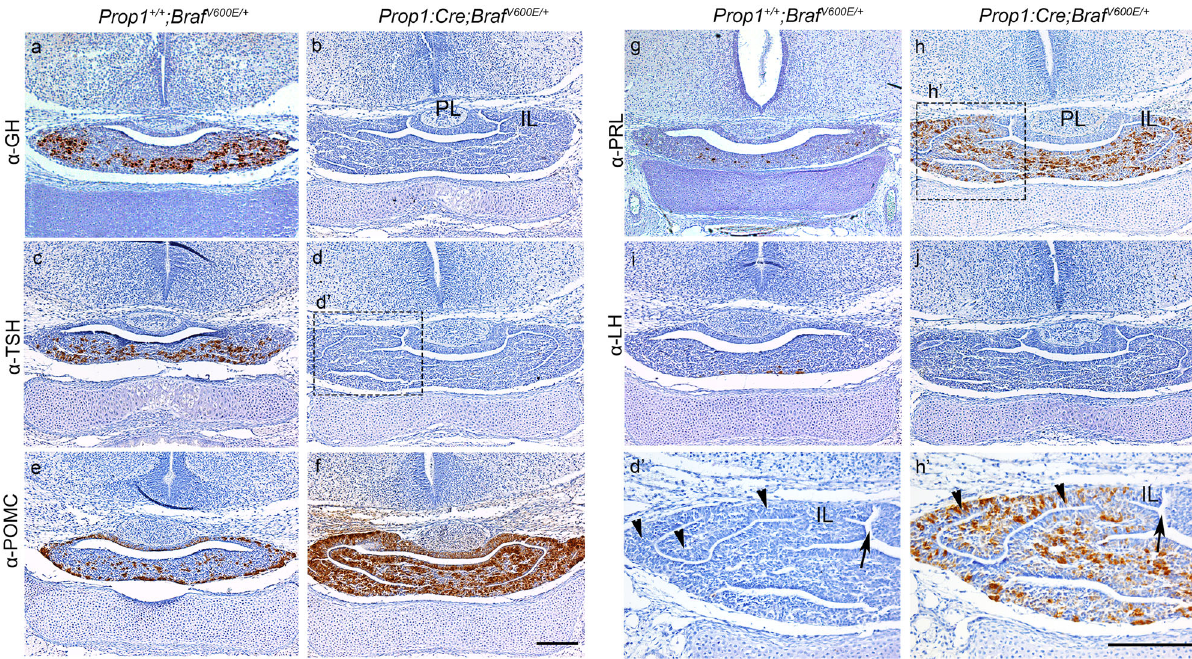
Fig. 4 Activation of the ERK/MAPK pathway in the anterior pituitary gland ( Prop1:Cre;Braf V600E/ + ) results in defective terminal differentiation of endocrine cells. a – j Immunohistochemistry against GH, TSH, POMC, PRL and LH in coronal sections through the pituitary gland of Prop1:Cre;Braf V600E/ + ( b , d , f , h , j ) and Wt ( a , c , e , g , i ) embryos at E17.5 of gestation. Absence of immunoreactivity for GH, TSH, LH in Prop1:Cre;Braf V600E/ + ( b , d , j ) mutant pituitaries compared to Prop1 + / + ;Braf V600E / + ( a , c , i ) reveals de fi cient terminal differentiation. Note that the anterior pituitary in Prop1:Cre;Braf V600E/ + is enlarged compared to Wt littermates. Prop1:Cre;Braf V600E/ + pituitaries exhibit an increase in POMC ( f ) and PRL ( h ) expression compared to Wt littermates ( e , g , respectively). d ′ , h ′ Higher magni fi cation views of the squared area in d and h , respectively, revealing an expanded intermediate lobe (IL arrowheads in d ′ and h ′ ) with multiple bifurcations (arrows in d ′ and h ′ ). Images are representative of three embryos per genotype. IL intermediate lobe, PL posterior lobe, GH growth hormone, TSH thyroid-stimulating hormone, POMC proopiomelanocortin, PRL prolactin, LH, luteinising hormone. Scale bar: f , 200 µ m; h ′ 500 µ Cre;Braf Q241R/ + pituitaries (Fig. 7b, h, k). Furthermore, the gonadotroph cell lineage marker, Sf1 , was reduced by in situ hybridisation in both Prop1:Cre;Braf V600E/ + and CAG:Cre; Braf Q241R/ + E15.5 pituitaries (Supplementary Fig. 11c, f, i), and